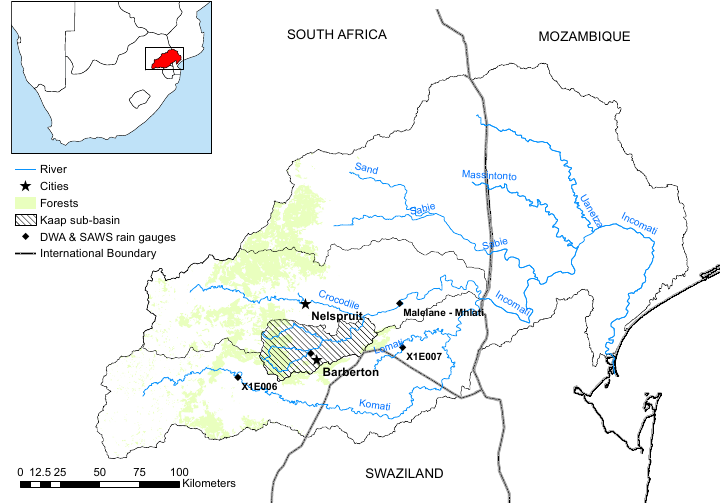
Figure 1. Location of the Kaap catchment in the Incomati Basin displaying nearby cities, and DWA and SAWS rain